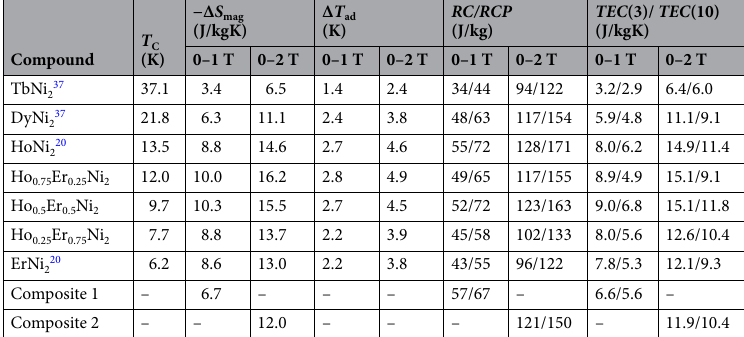
ad for Ho 0 . 75 Er 0 . 25 Ni 2 reaches 2.8 K (4.9 K) at 12.0 K, and, with increasing Er content, the maximum